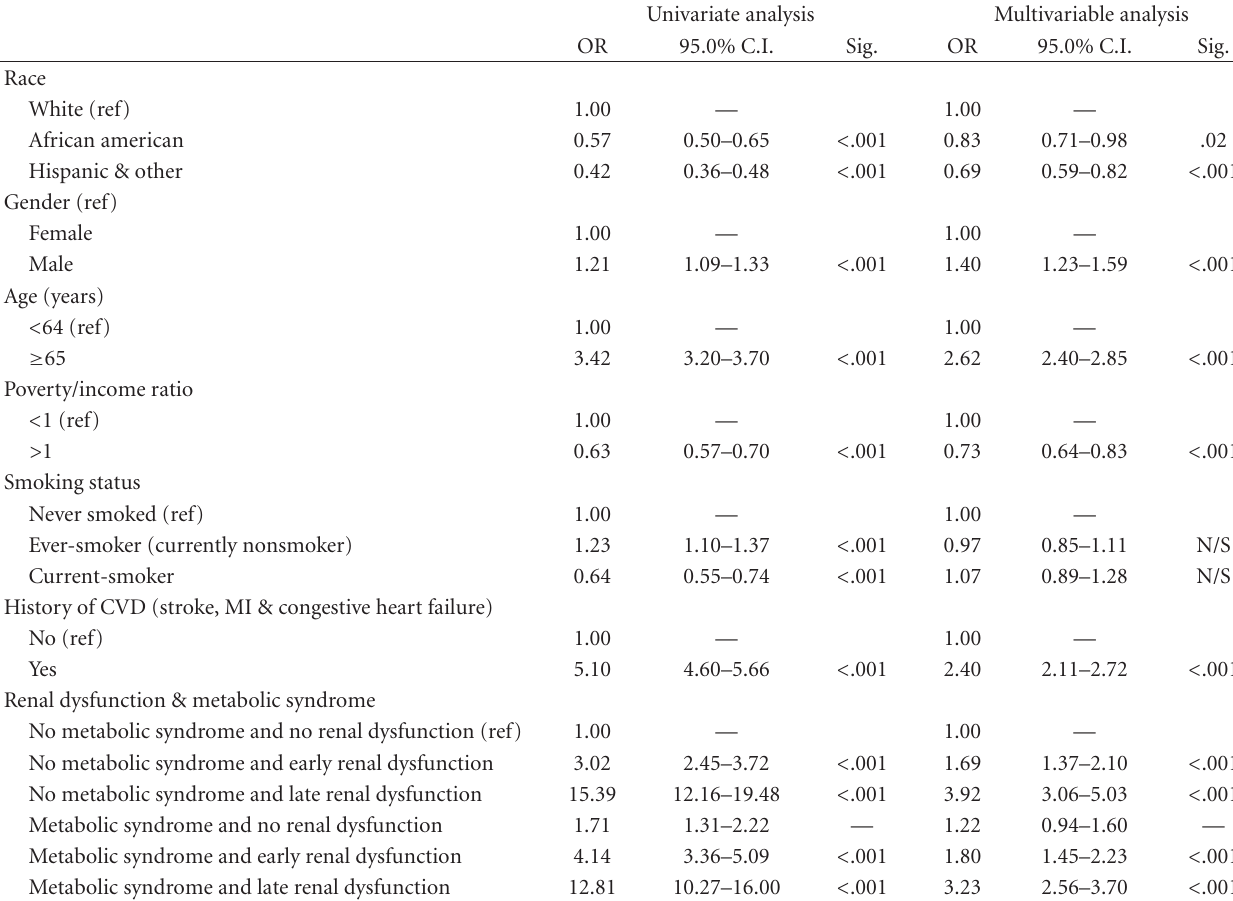
Table 3: Univariate and Multivariable Cox Regression Analysis Cardiovascular Disease Mortality versus Independent Variables ( n = 13115).